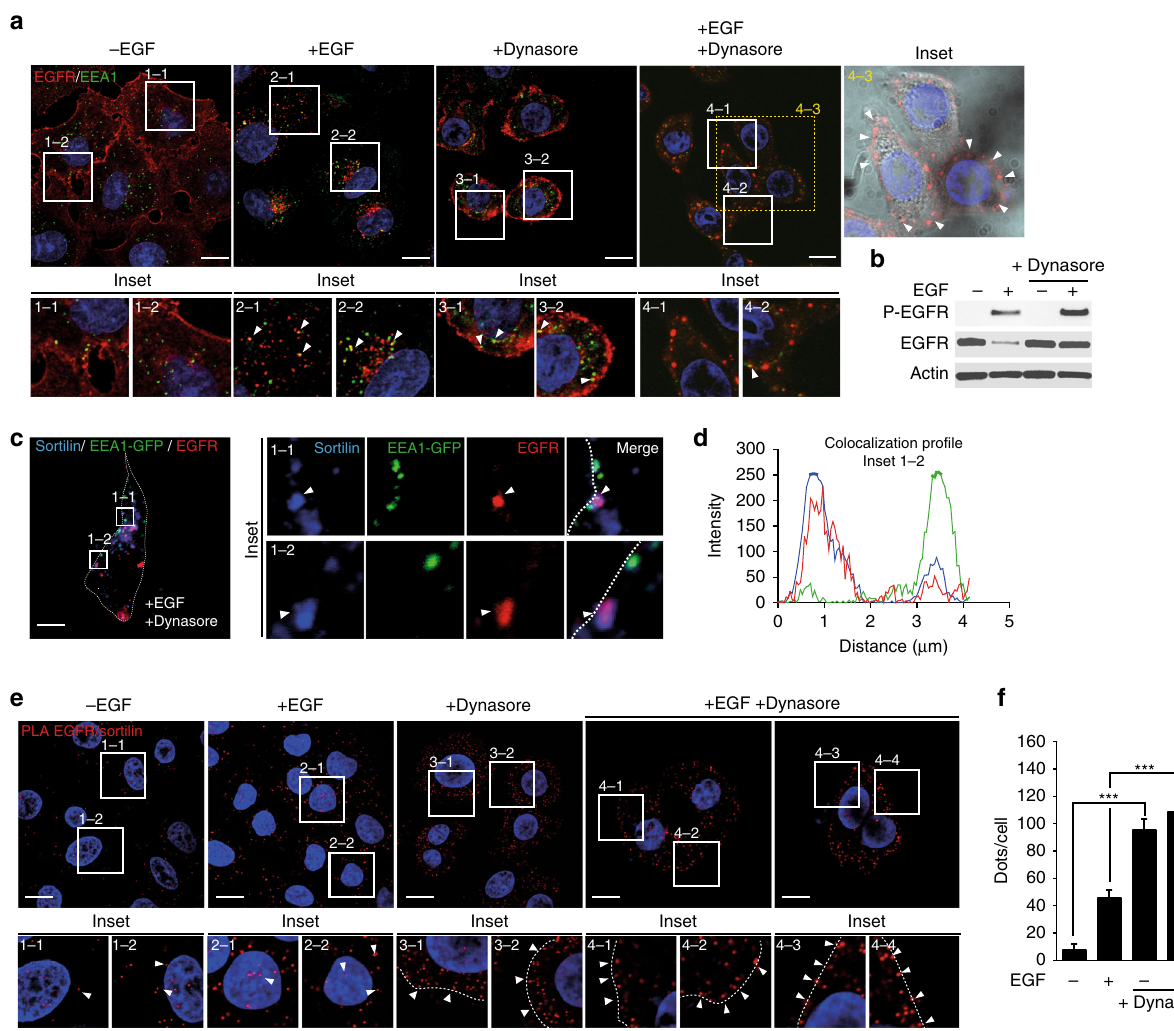
Fig. 2 EGFR interacts with sortilin at the cell surface. a A549 cells were pretreated or not with the cell-permeable dynamin inhibitor Dynasore (40 µ M) for 2 h, and then stimulated or not with EGF (50 ng/mL) for 15 min. Cells were immunolabeled for EGFR and the early endosome marker EEA1, and